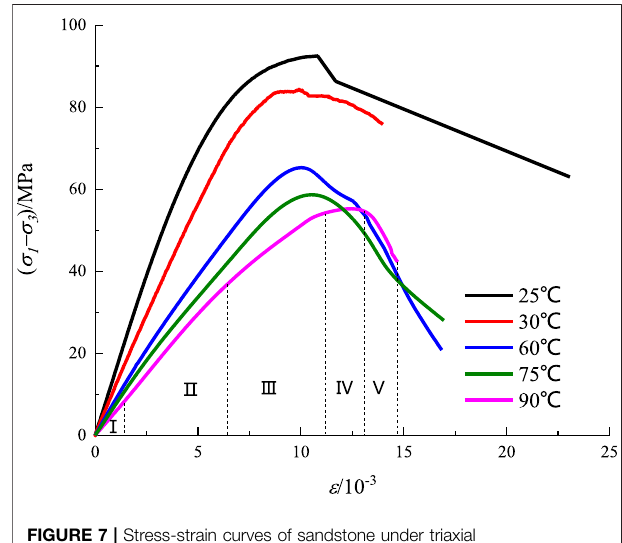
FIGURE 6 | Elastic modulus of sandstone under different con fi ning pressures.